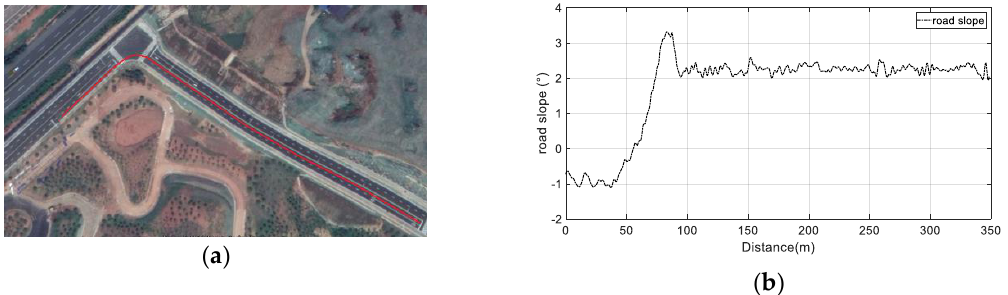
Figure 21. The experiment scene. ( a ) Desired path. ( b ) Road slope.